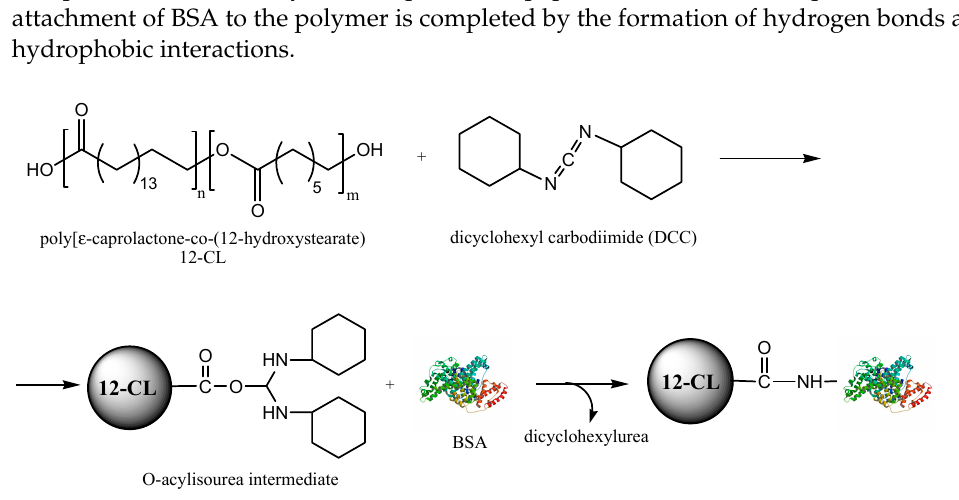
Figure 1. Reaction scheme of the 12CL polymer activation with BSA by cross-linking with dicyclo- hexyl carbodiimide (DCC).